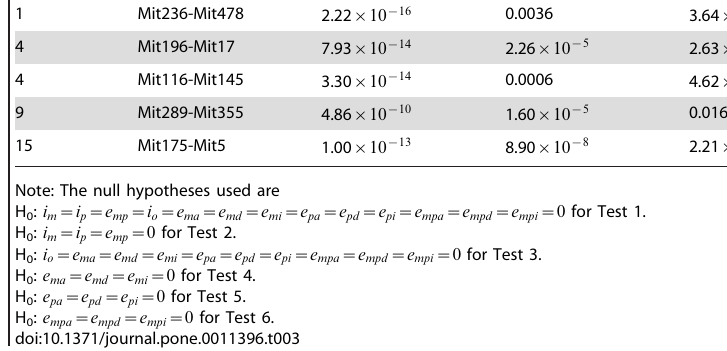
Table 3. P -values for testing the imprinting effects of iQTLs expressed at different levels.